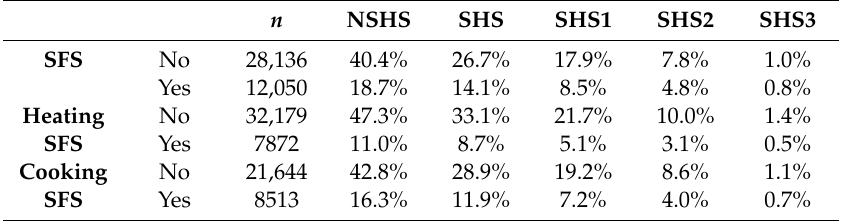
Table 2. Percentages of children with co-exposure to SHS and solid fuel smoke